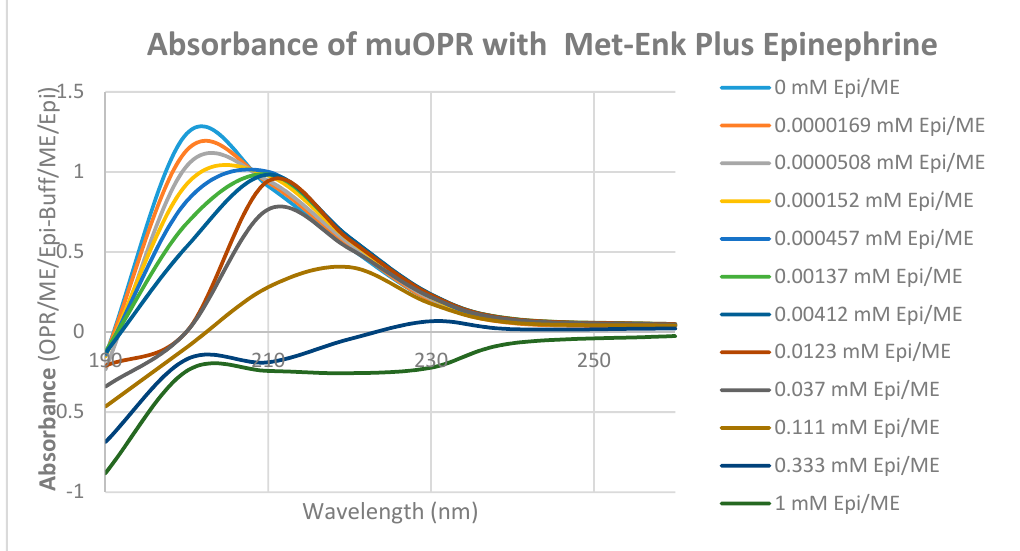
Figure 14. UV spectra of mu opioid receptor (OPR) with serial additions of both met-enkephalin (Met-Enk) and epinephrine (Epi) in tandem. Note the obvious differences from Figures 12 and 13.